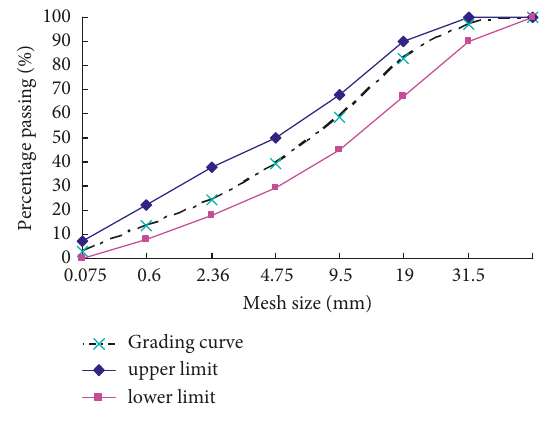
Figure 6: Grading RCA.